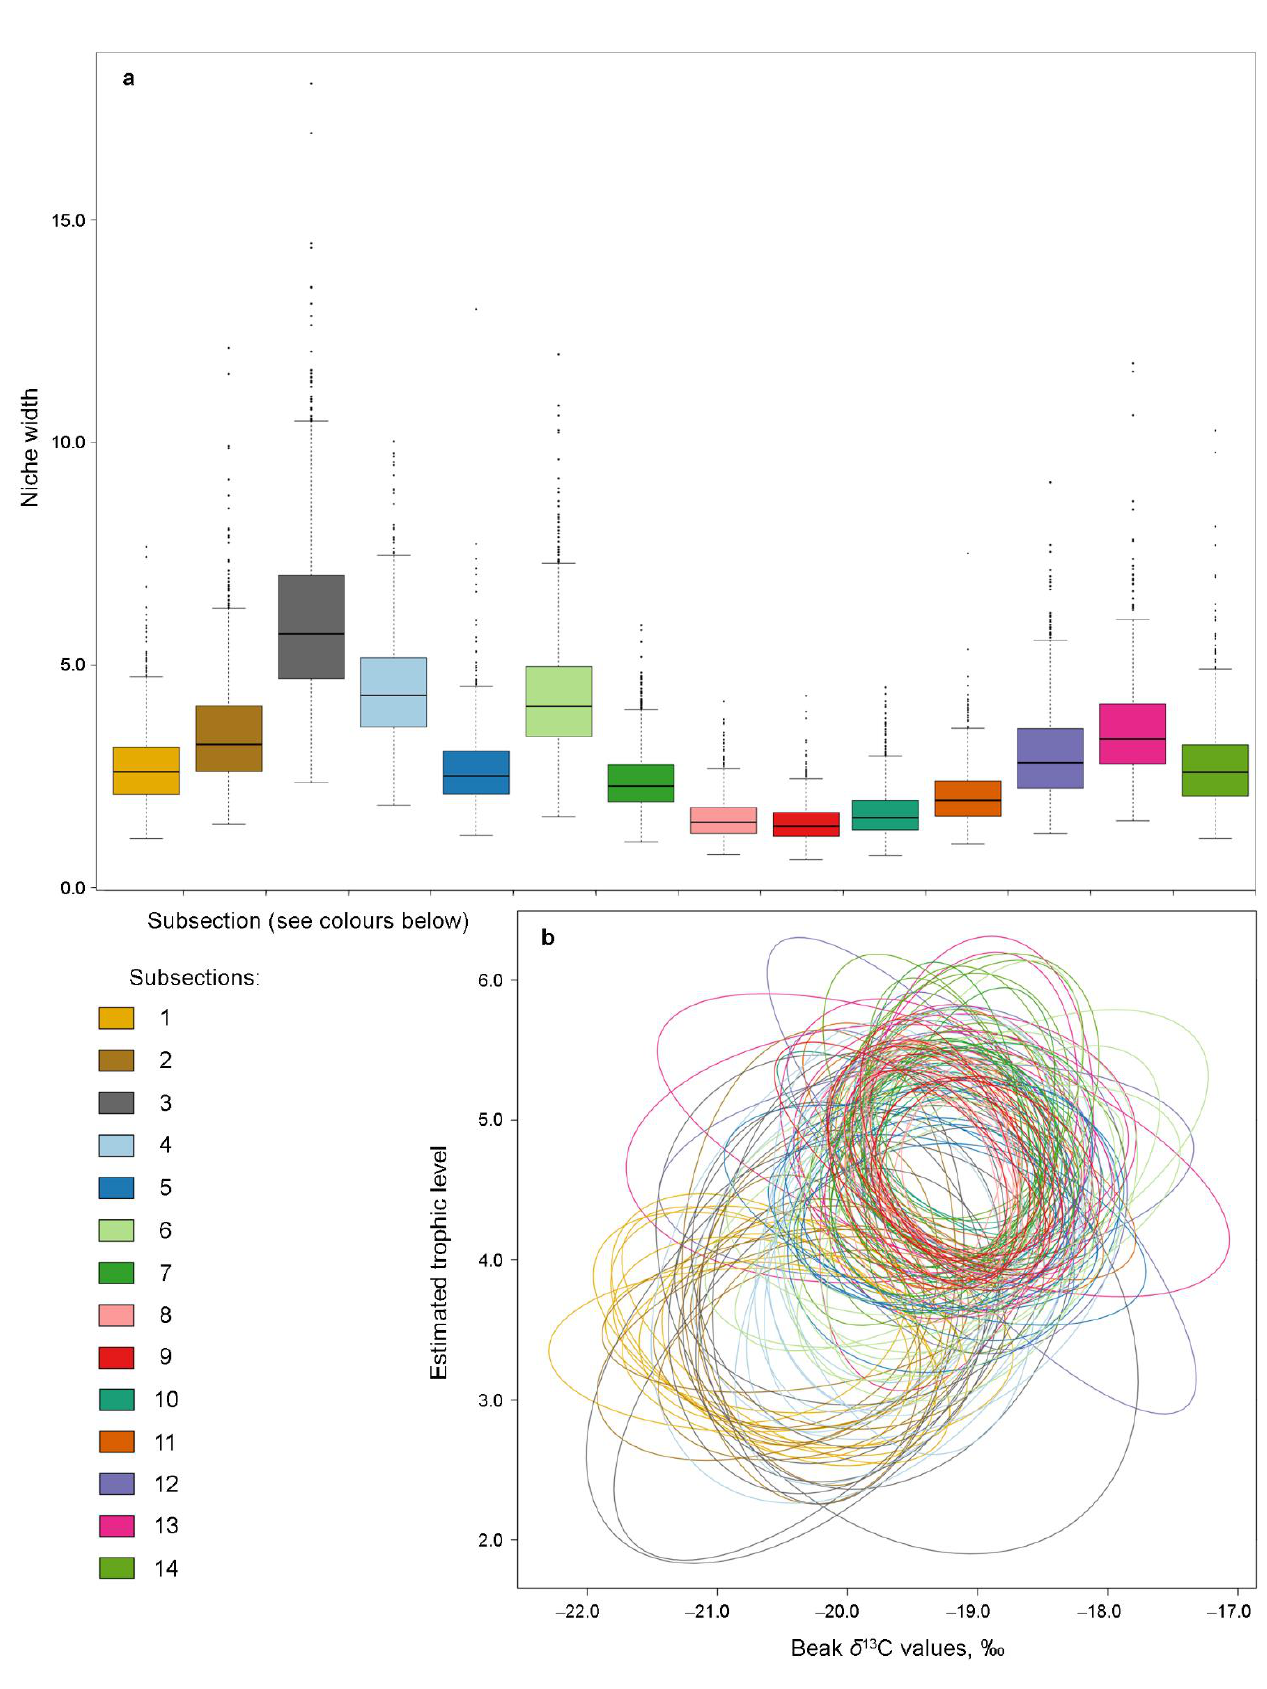
Figure 4. Isotopic niche width ( a ) and plot of ten random elliptical projections of niche region for each subsection ( b ) among the upper beak subsections of Gonatus fabricii , estimated in nicheROVER 1.1.0.